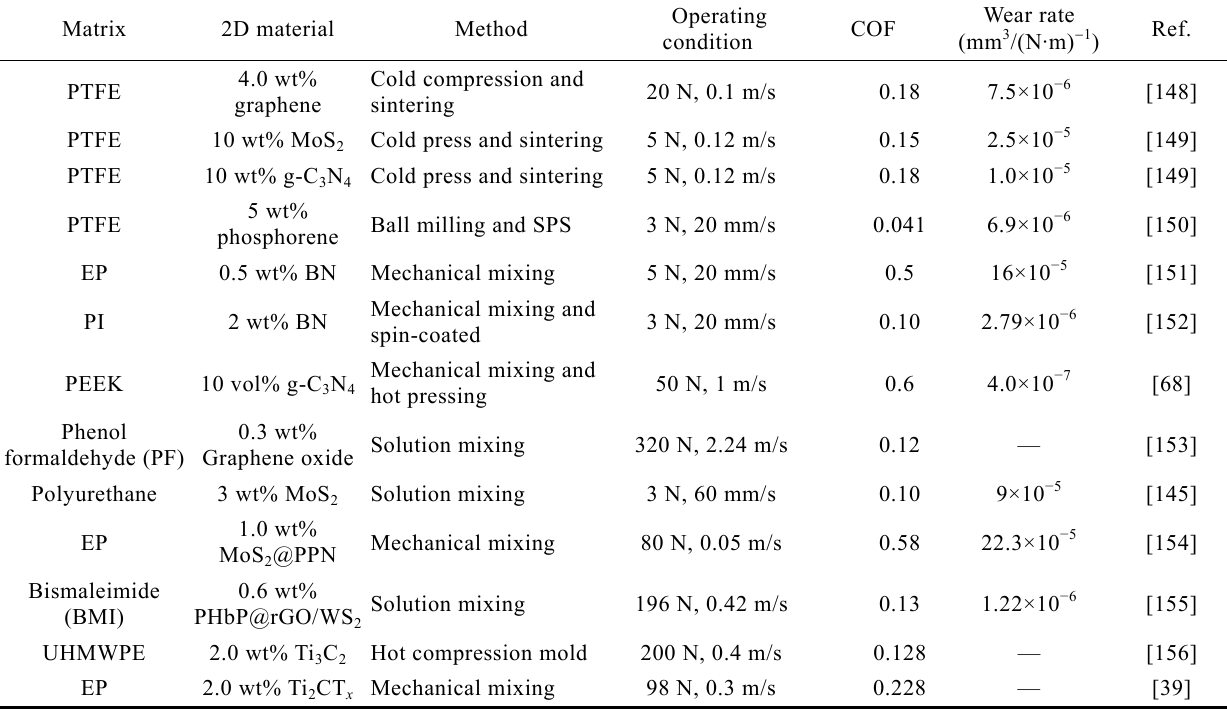
Table 4 Tribological properties of polymer composites reinforced with 2D materials. Matrix 2D material